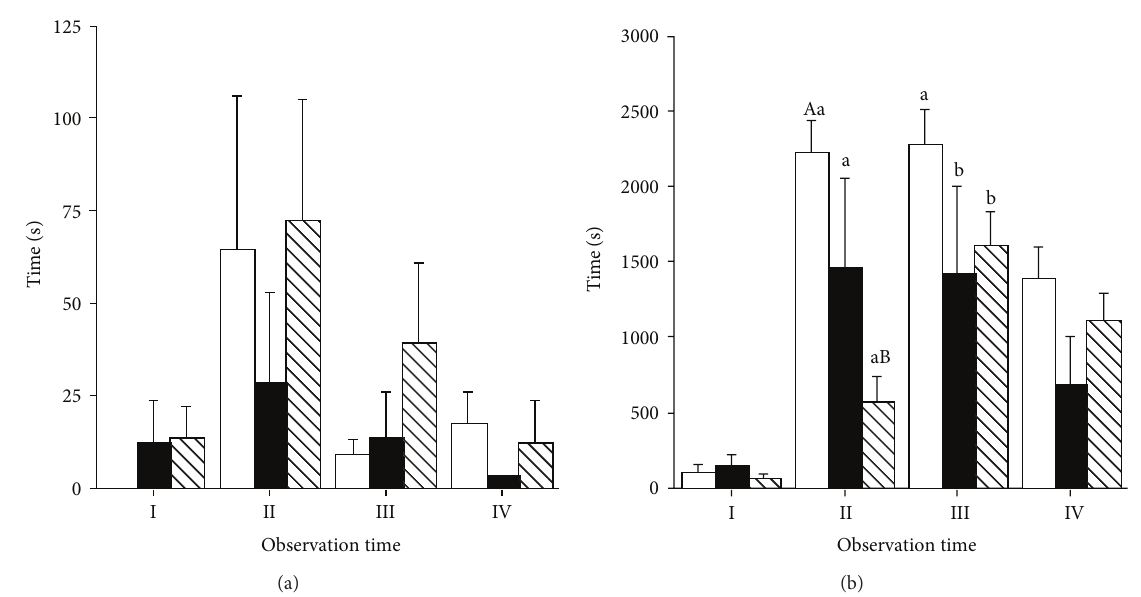
Figure 3: Effect of different types of physical exercise (race blank; maximal exercise shaded; daily exercise lined) on drinking (a) and eating activity (b) of Standardbred horses housed in single stalls. Mares were examined at rest in their stalls (Time I), immediately after exercise (Time II), one (Time III), and two hours (Time V) after the completion of exercise. Values are expressed as means ± SE. For parameters where a significant effect of type of exercise × time interaction was noted, means with different capital and low letters indicate significant difference ( 𝑃 < 0.01 and 𝑃 < 0.05 , resp.) between types of